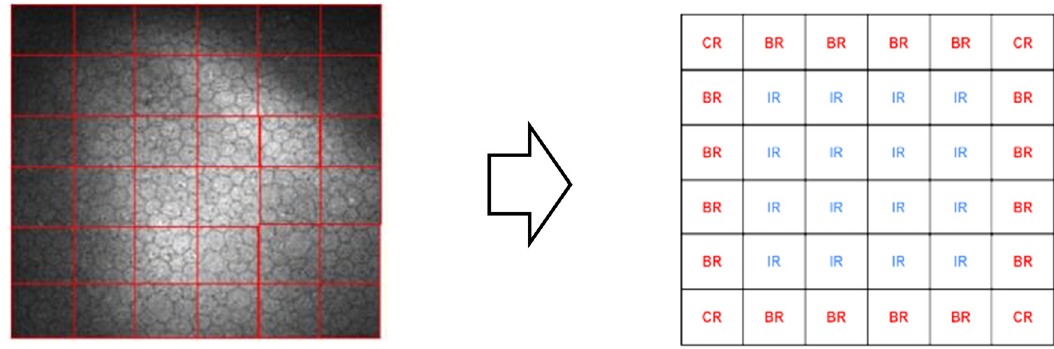
Figure 4: Block creation by dividing the image into 36